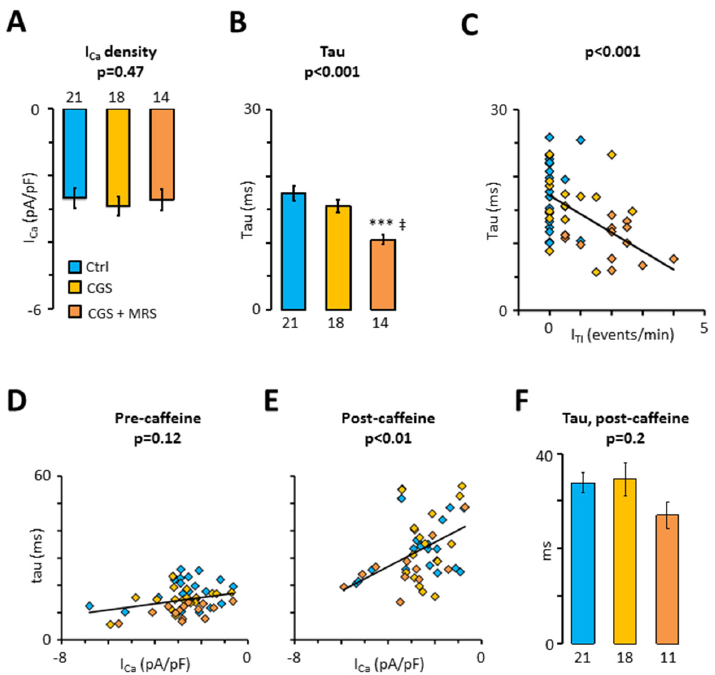
Figure 5. Impact of the crosstalk between A 3 R and A 2A R on L-type calcium current. ( A ) I Ca density; ( B ) fast time constant, tau, for I Ca decay; ( C ) correlation between tau and I TI frequency (from Figure 3A); ( D – E ) correlation between tau and I Ca density before and after transient exposure to 10 mM caffeine. Currents were recorded in 19 patients before (blue) and after perfusion of myocytes with CGS21680 (yellow) and CGS21680 + MRS1191 (orange). Statistical significance was evaluated using Pearson’s product-moment correlation; ( F ) Time constant, tau, for the decay of the first I Ca after transient exposure to caffeine. Significant differences between control and treatments are indicated with; *** p < 0.001, ‡ p < 0.01 for CGS21680 + MRS1191 vs. CGS21680. Data were analyzed using ANOVA ( p -values are given above the bars) and Tukey’s post-test in ( A , B , F ). Number of cells are given below bars. 3. Discussion 3.1. Main Findings While the A 3 R has been attributed an important role in preconditioning and cardio protection [10,19], little is known about its functional role in human atrial myocytes. Here, we analyzed the impact of the A 3 R on intracellular calcium homeostasis and report that even though A 3 R mRNA expression is modest compared to the expression of the A 1 R and the A 2A R, endogenous activation of the A 3 Rs at baseline blunts the incidence of the spontaneous calcium release-induced I TI . Furthermore, crosstalk between A 3 R and A 2A R upon activation of both receptors reduces the incidence of both calcium sparks and I TI ,